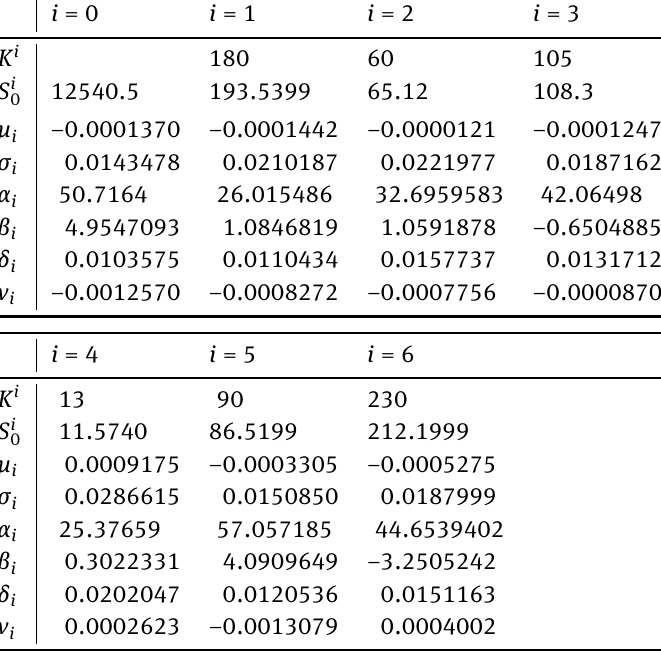
Table 2: Empirical Pearson correlation ˆ ρ T from log-return data ( x i 95% -confidence interval for ˆ ρ T